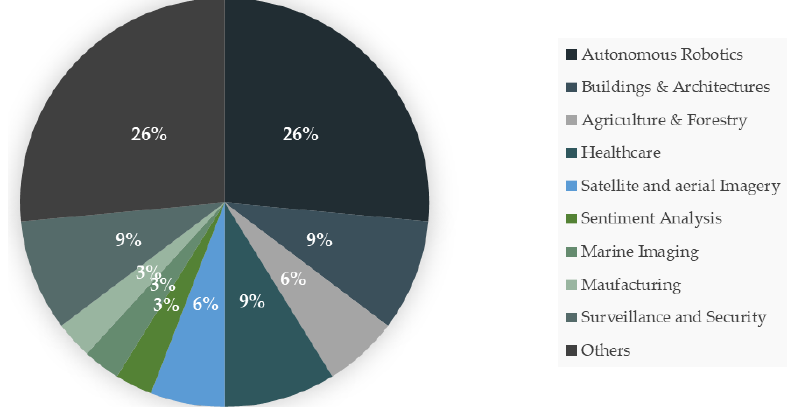
Figure 1. Application Domains involving Visual Extremes.